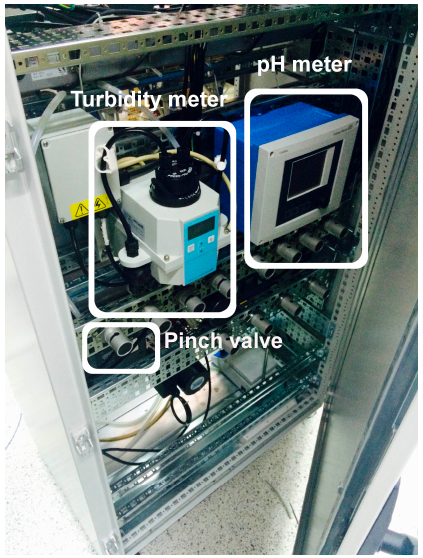
Figure 11. Rear view of the prototype.